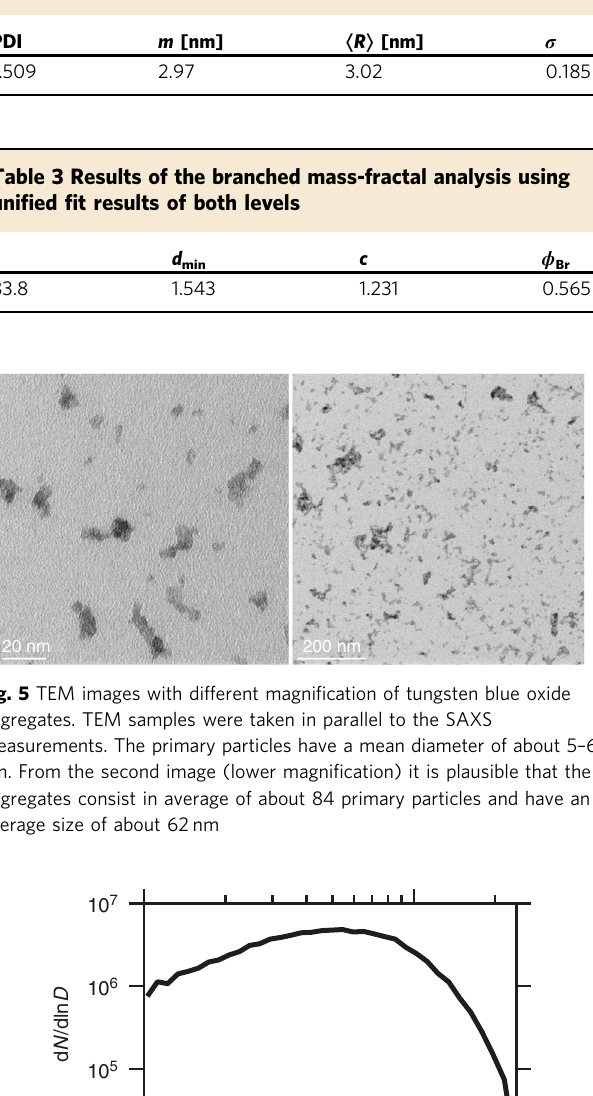
Table 2 Results of the size distribution analysis using uni fi ed fi t results of level 1